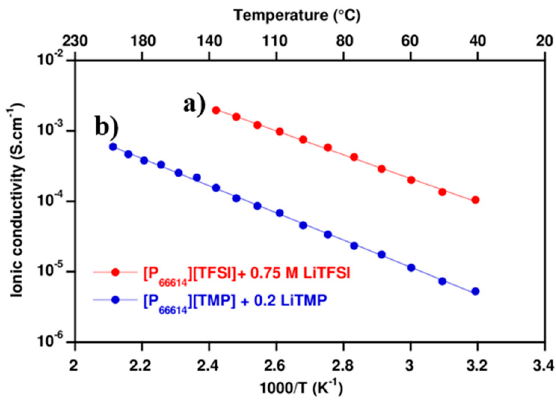
Figure 1. Ionic conductivity of phosphonium electrolytes with two types of anion: (a) [P 66614 ][TFSI] with 0.75 M of LiTFSI and (b) [P 66614 ][TMP] with 0.2 M of LiTMP.